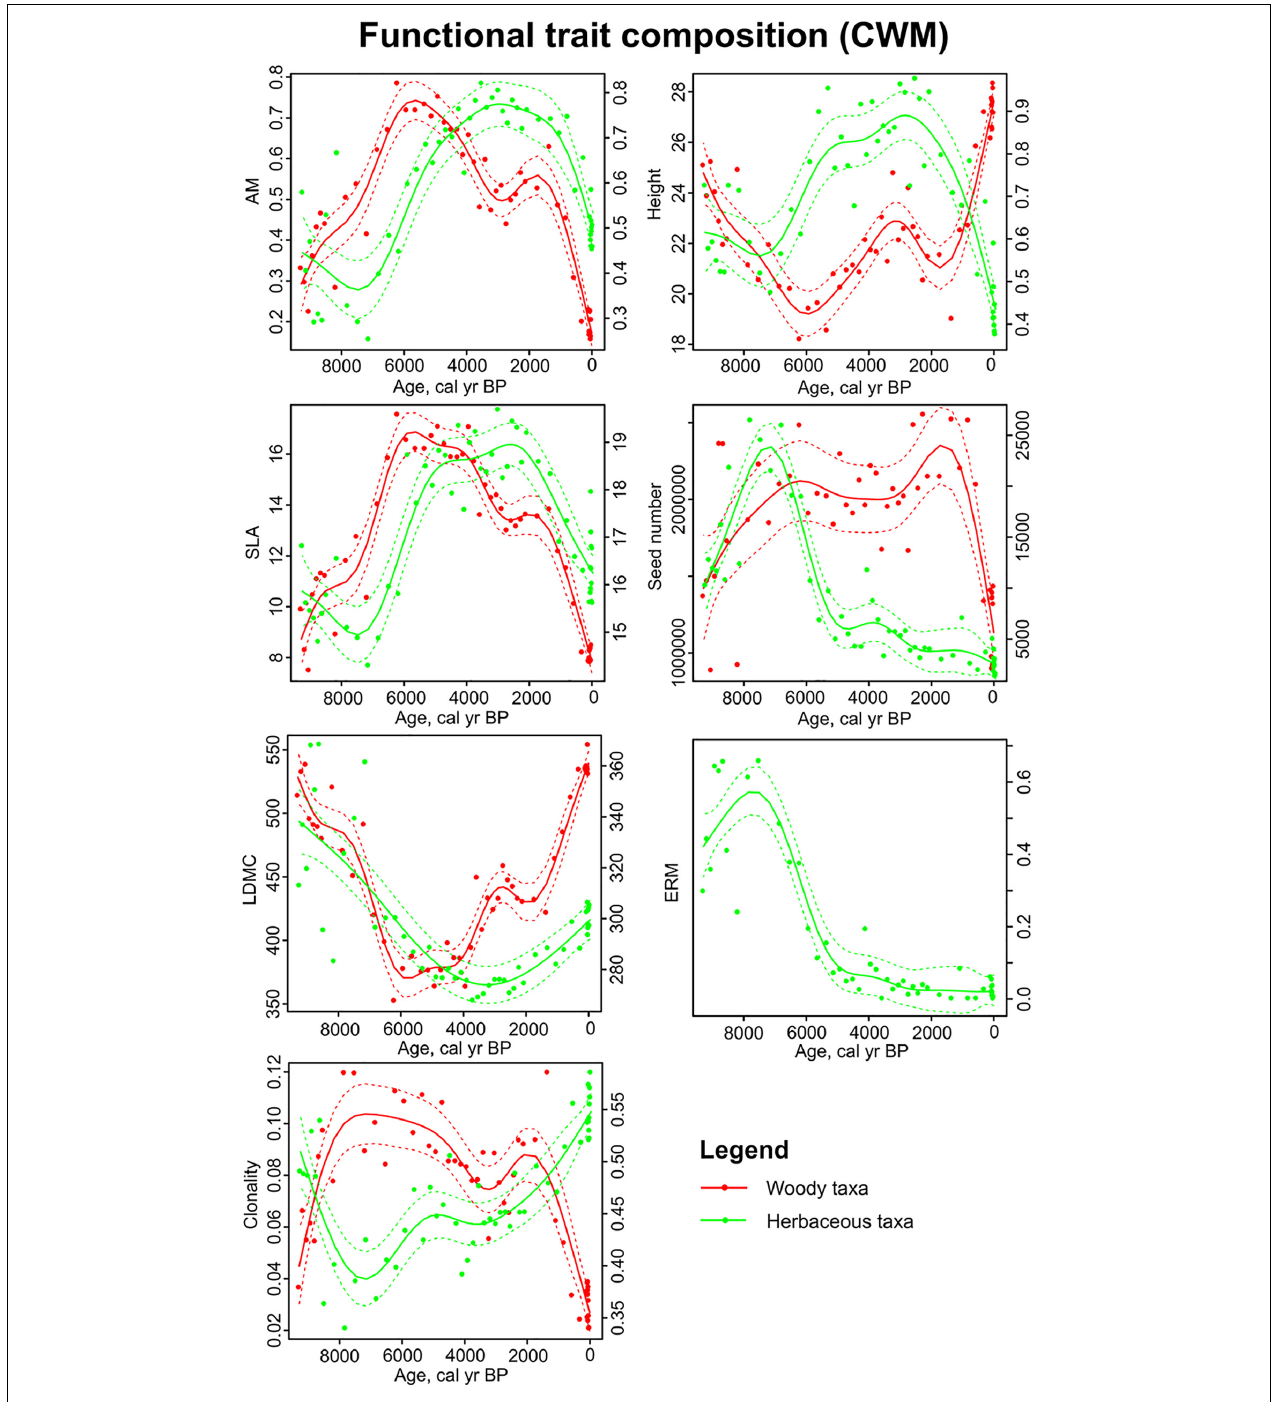
FIGURE 5 | Sedimentary pollen based reconstructions of functional trait composition (CWM) in Kanna spring fen. Generalized additive models in relation to time for woody (red line) and herbaceous taxa (green line). Red and green dashed lines enclose the 95% confidence intervals of trend lines. Traits of herbaceous taxa is plotted on the secondary y-axes. Abbreviations of trait names are explained in Table 1